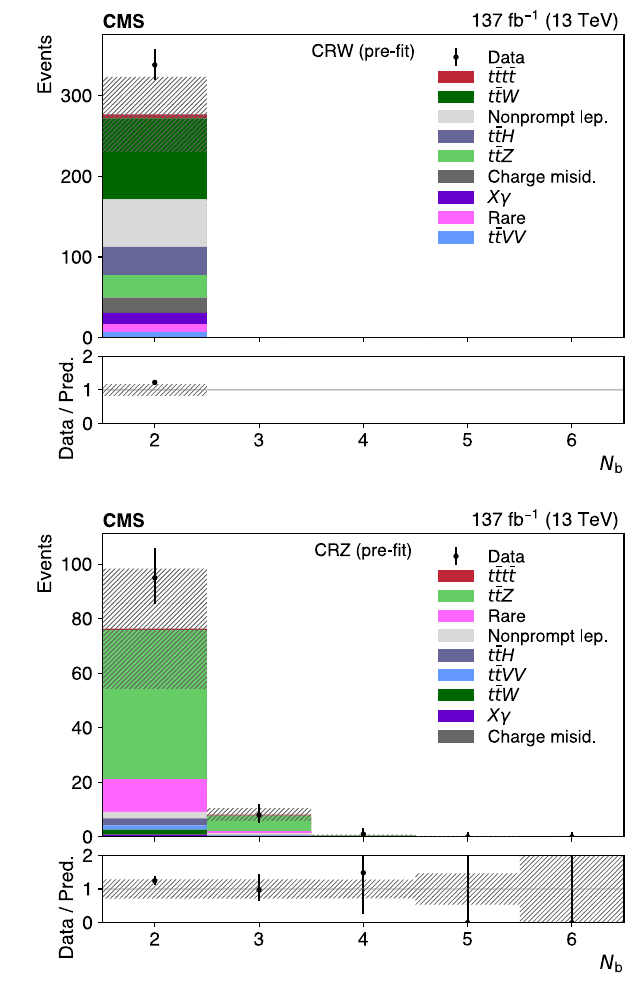
Fig. 3 Distributions of N jets (left) and N b (right) in the ttW (upper) and ttZ (lower) CRs, before fitting to data. The hatched areas represent the uncertainties in the SM signal and background predictions. The tttt